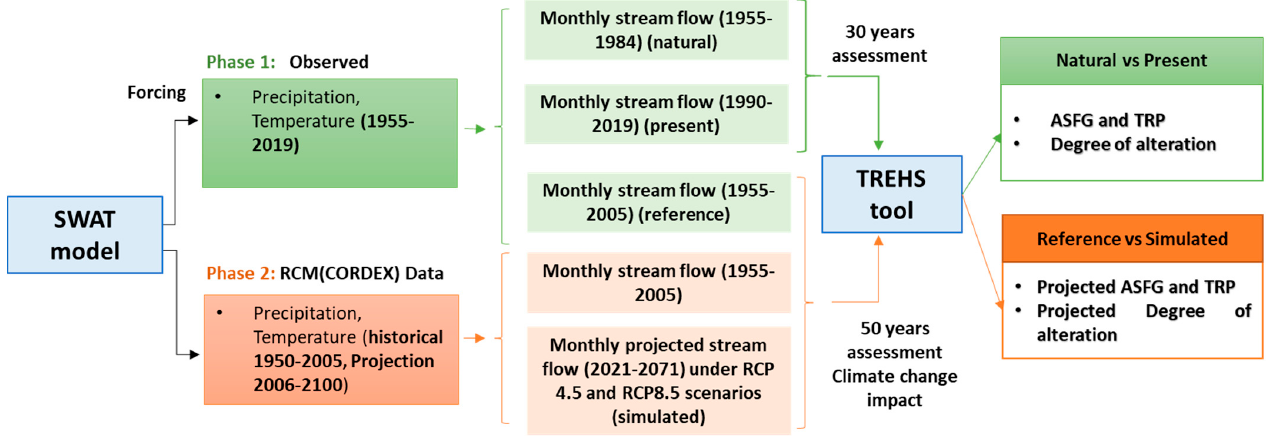
Figure 4. Flowchart of temporary regime assessment.